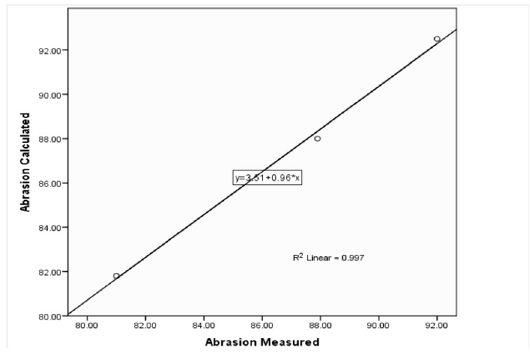
Figure 14. Abrasion vs. Abrasion